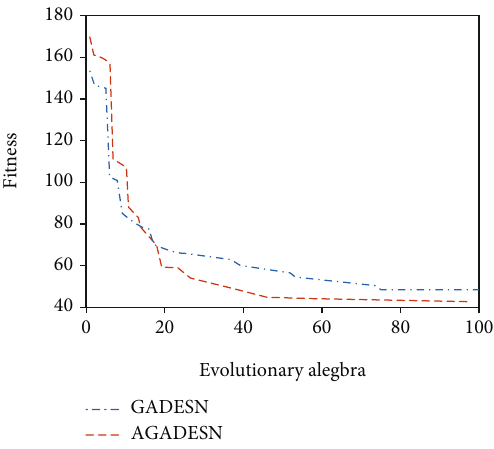
Figure 9: Adaptive genetic algorithm and genetic algorithm fi tness value iteration